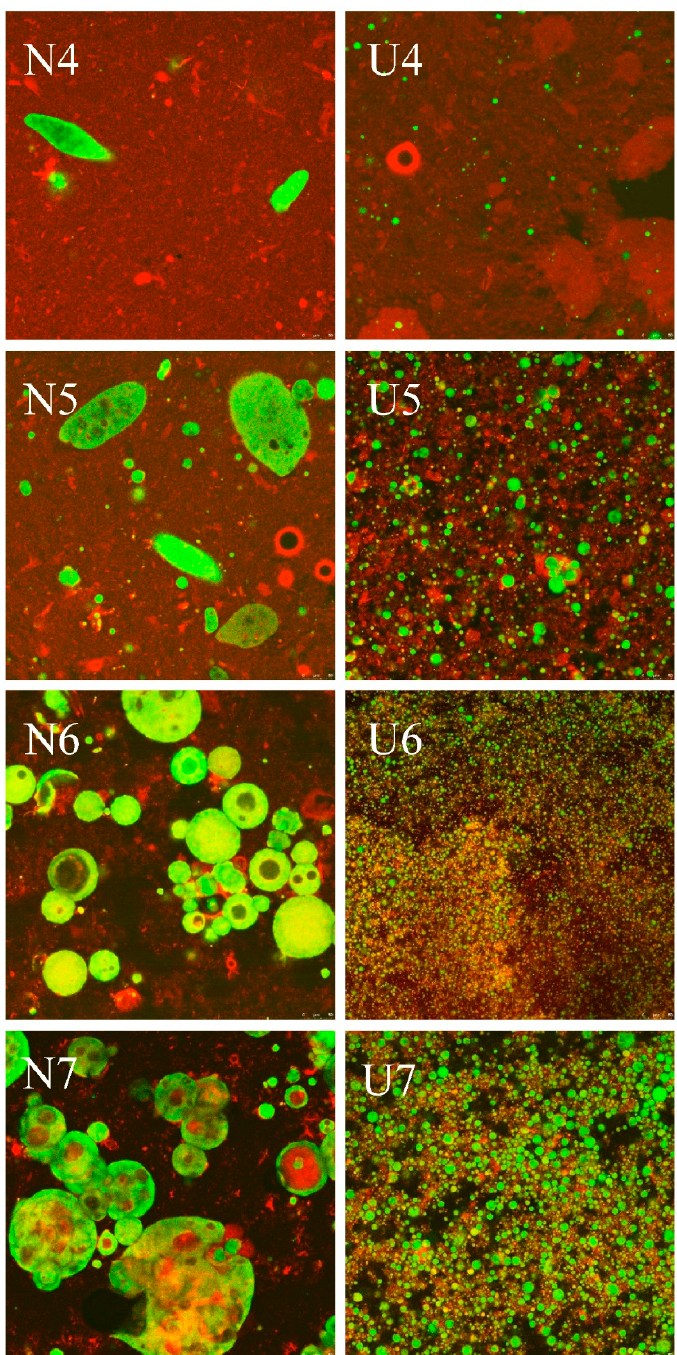
Figure 3. The CLSM images of myofibrillar protein pork fat emulsions as affected by high-intensity ultrasound emulsification. The red color represents MP, and green color represents pork fat in this figure.